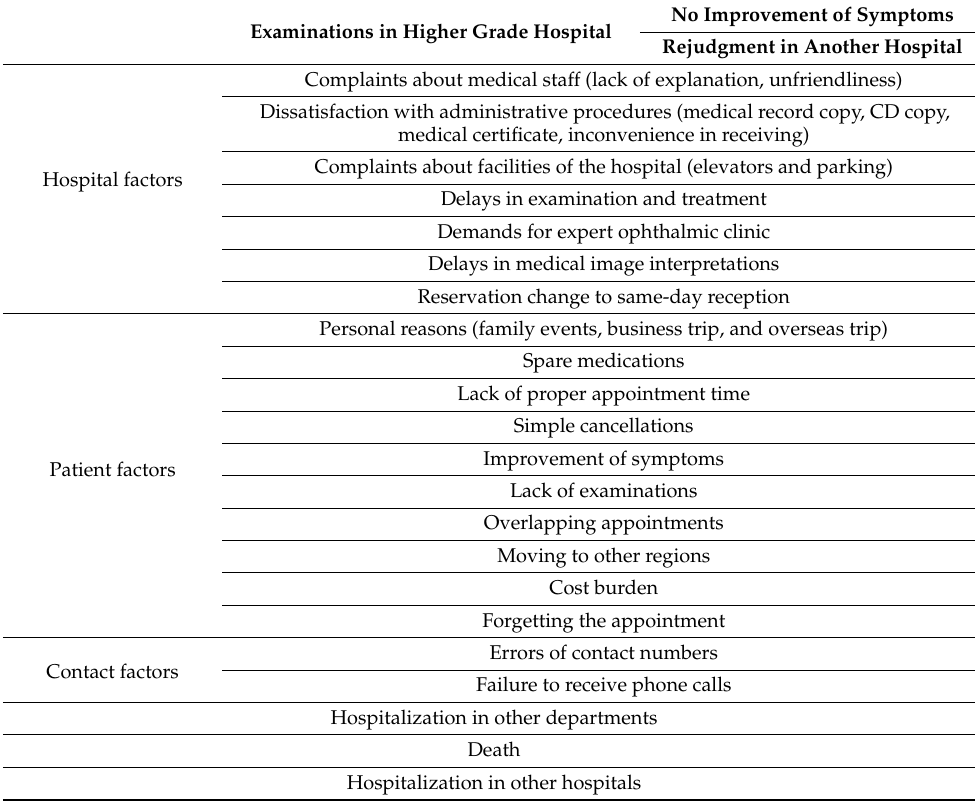
Table 4. Reasons for not visiting the clinic.